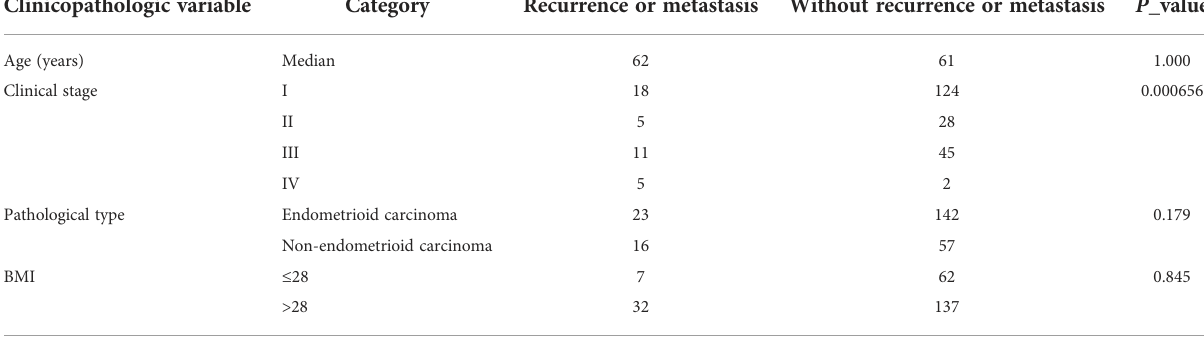
TABLE 1 Summary of clinical information of patients with EC.